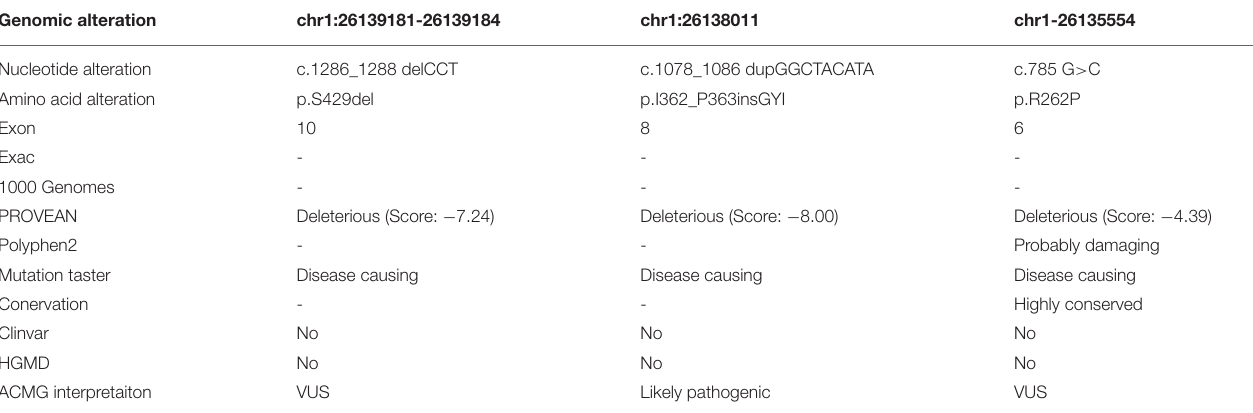
TABLE 2 | Novel mutations detected in four patients with SEPN1-RM and their pathogenesis